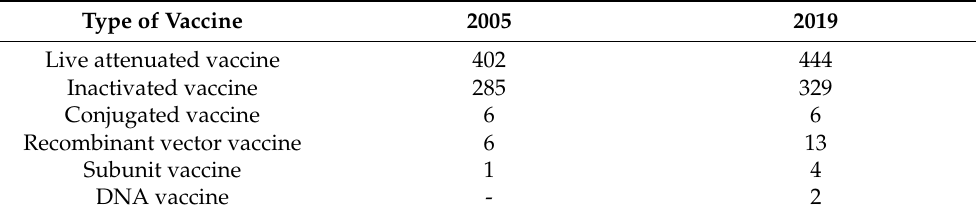
Table 1. Vaccine world production values compiled from World Animal Health Information System (WAHIS) interface in 2005 and